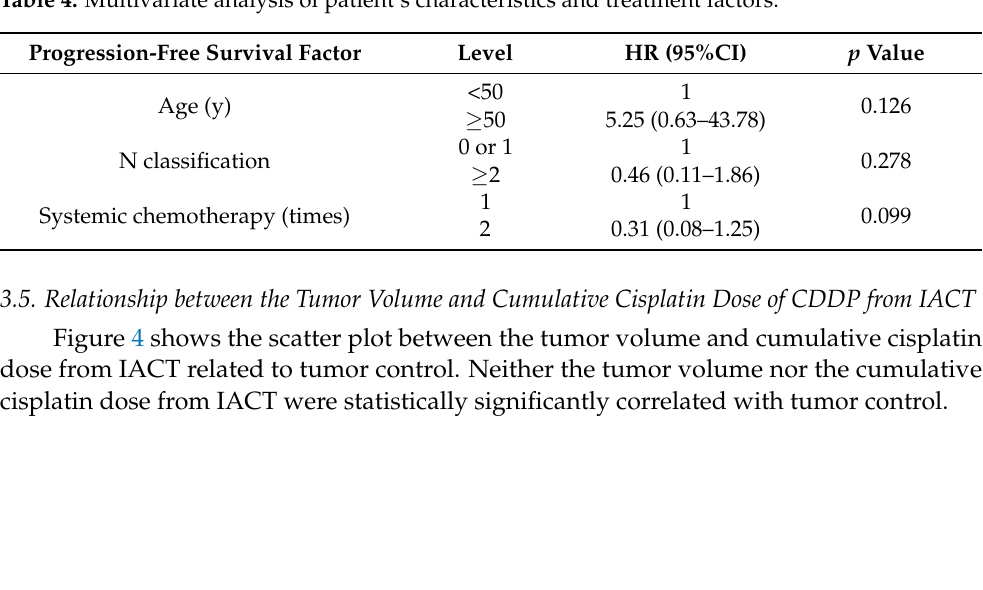
Table 4. Multivariate analysis of patient’s characteristics and treatment